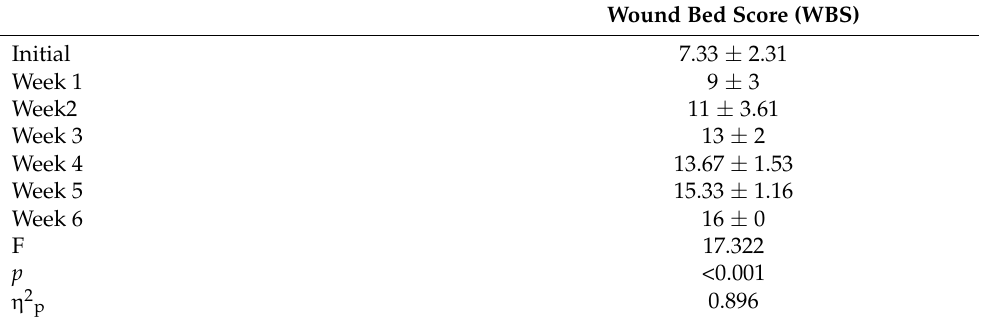
Table 6. Simple contrast results for the WBS.